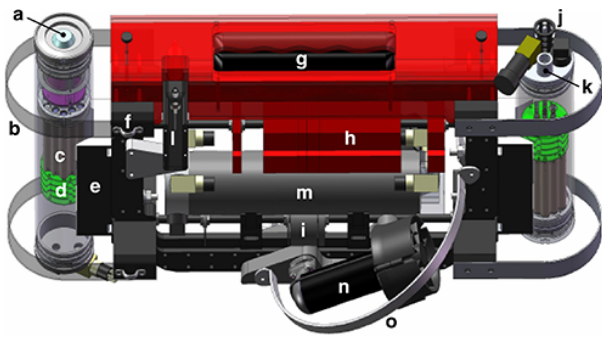
Figure 1. The principal components of the next-generation C-OPS backplane with C-PrOPS (roll is the long axis and pitch is the short axis into or out of the page), as follows: (a) irradiance cosine col- lector; (b) radiometer bumper; (c) array of 19 microradiometers; (d) aggregator and support electronics; (e) rotating V-block for pitch adjustment; (f) two-point harness attachment; (g) hydrobaric buoy- ancy chamber, which accommodates up to 3 compressible bladders; (h) slotted flotation and (i) bronze weights for buoyancy and roll ad- justment; (j) water temperature probe and (k) pressure transducer port on the radiance end cap; (l) conductivity sensor; (m) elec- tronics module; (n) digital thruster (one of two, on each side); and (o) thruster guard. The aggregator and support electronics control the 19 microradiometers as a single device. The side bumpers and thruster guards protect the radiometers and digital thrusters from unanticipated side impacts,